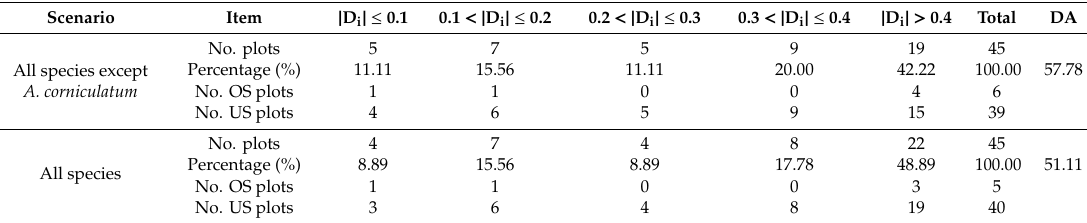
Table 5. Accuracy assessment of individual tree segmentation in number aspect. OS: over-segmentation, US: under-segmentation.